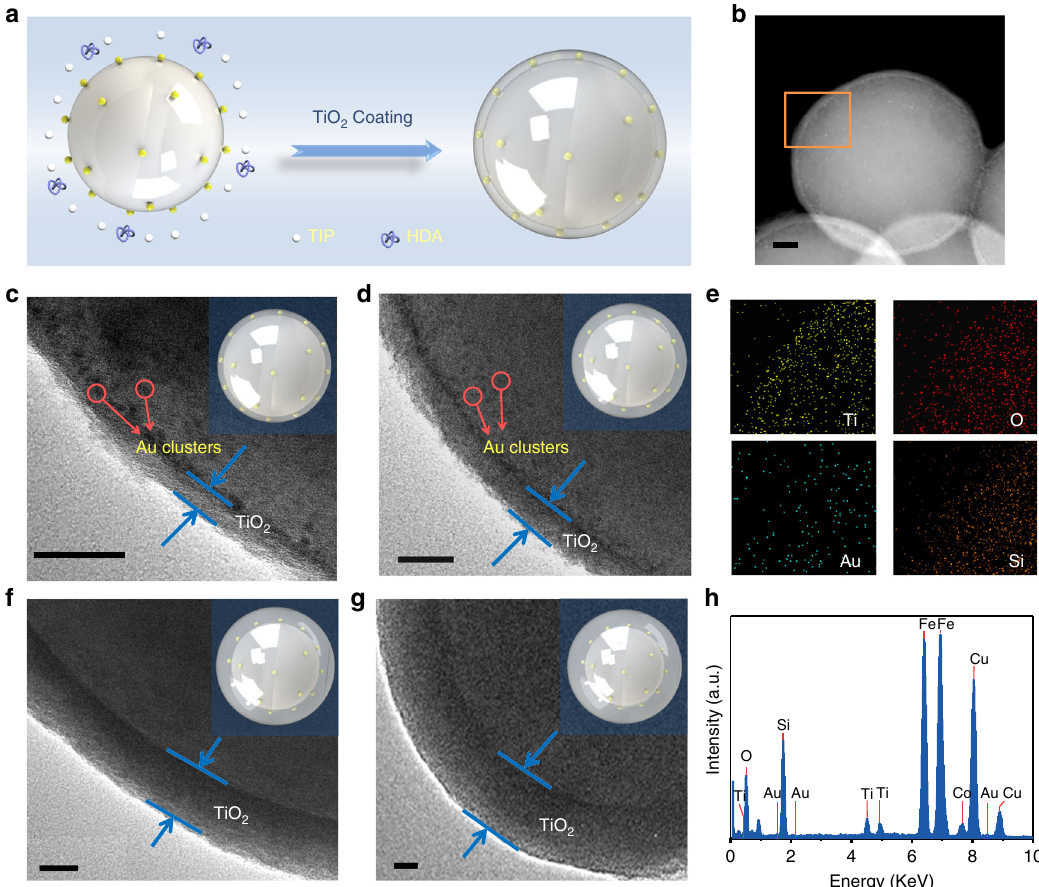
Fig. 2 Morphology and chemical composition of SABT samples. a Schematic illustration of fabrication process for core-shell SiO 2 -Au GSH clusters- BPEI@TiO 2 (SABT) composites; b high-angle annular dark- fi eld scanning transmission electron microscopy (HAADF-STEM) image (scale bar, 50 nm); e elemental mapping results; and h energy-dispersive X-ray (EDX) spectrum for the boxed area in the main image of SABT-0.05; TEM images of c SABT- 0.05, d SABT-0.1, f SABT-0.15, and g SABT-0.2, scale bar, 20 nm. Insets in the c , d , f , and g are the corresponding models of SABT with different TiO 2